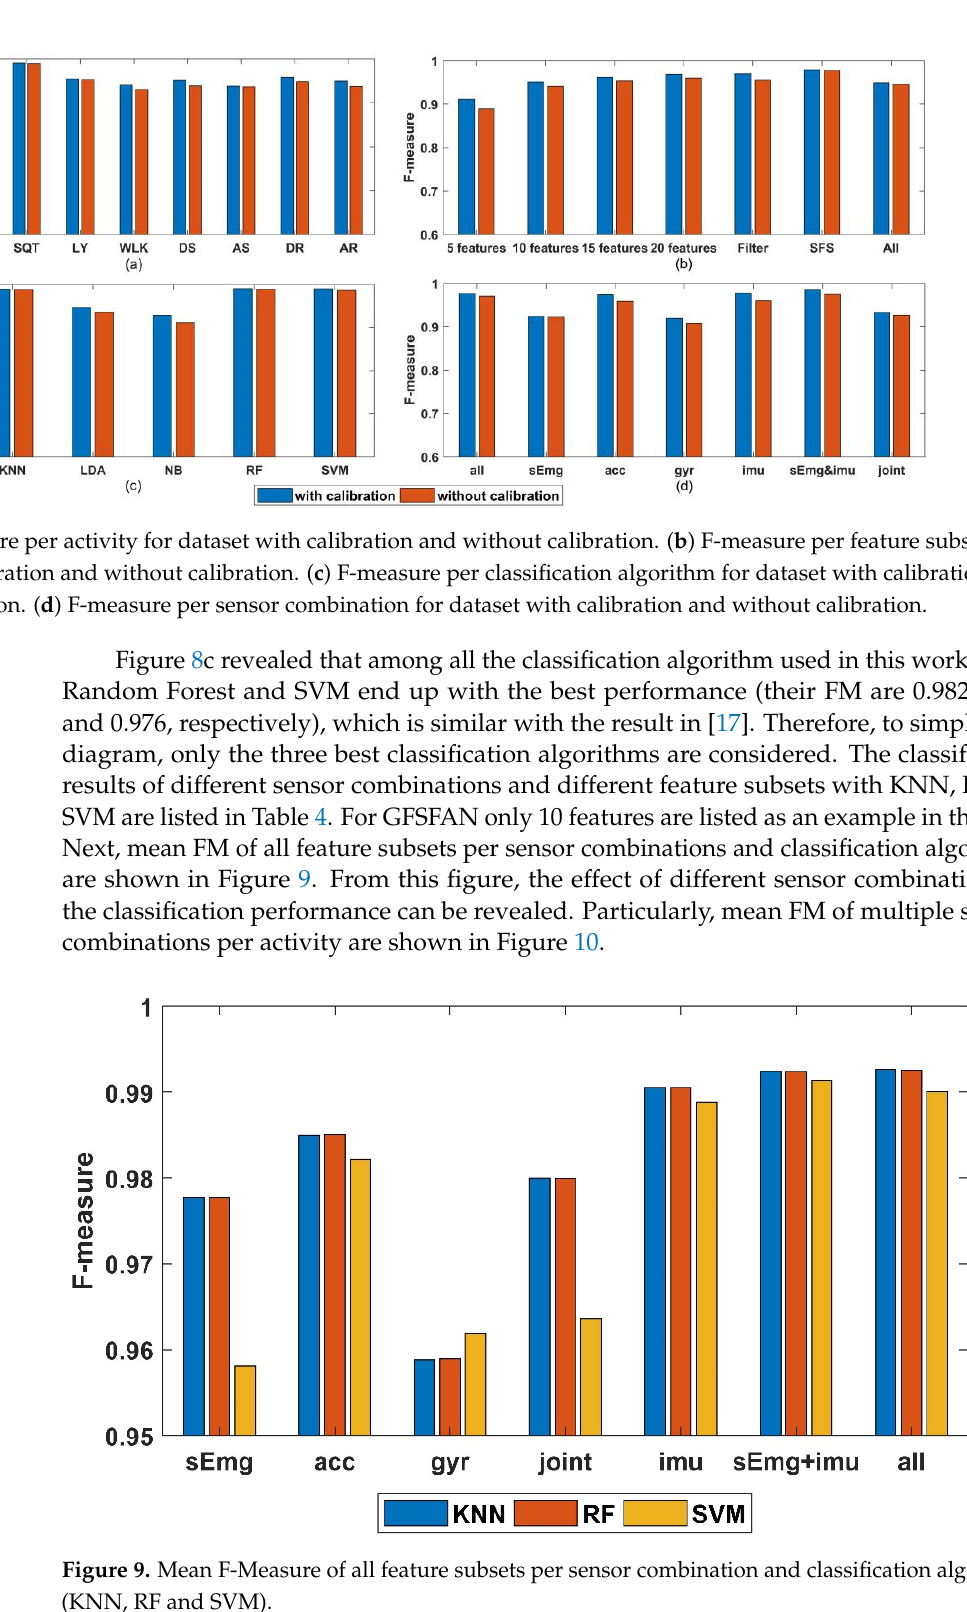
Figure 9. Mean F-Measure of all feature subsets per sensor combination and classification algorithms (KNN, RF and SVM).